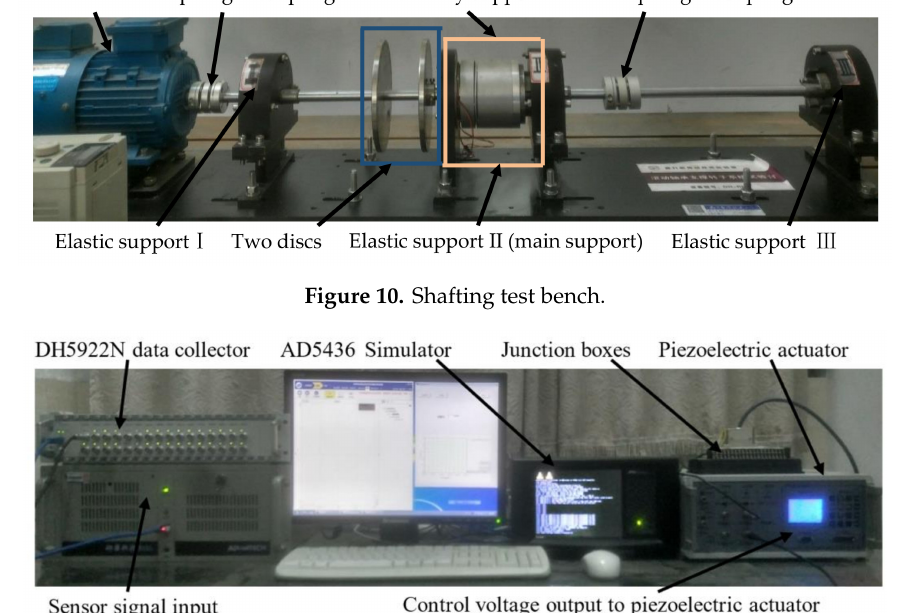
Figure 11. Layout of test data acquisition device.